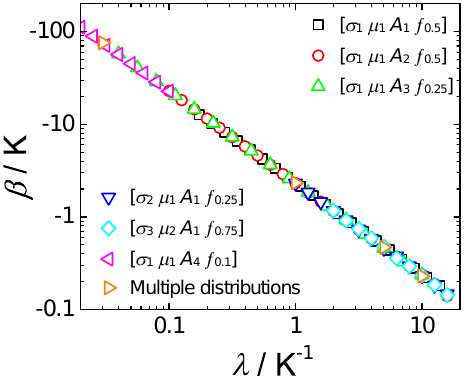
Figure 2. Illustration of how the systematic shift in temperature ( β) observed for a change in cooling rate is independent of the variability in ice nucleating ability. f (T ) curves shown are for a uniform ( σ = 0.01) and diverse ( σ = 20) INP population where λ = 2K − 1 , and cooled at constant rates of 1Kmin − 1 (solid line) and 10Kmin − 1 (dashed line). β corresponds to the shift in temper- ature (K) observed when 50% of the droplets have frozen.